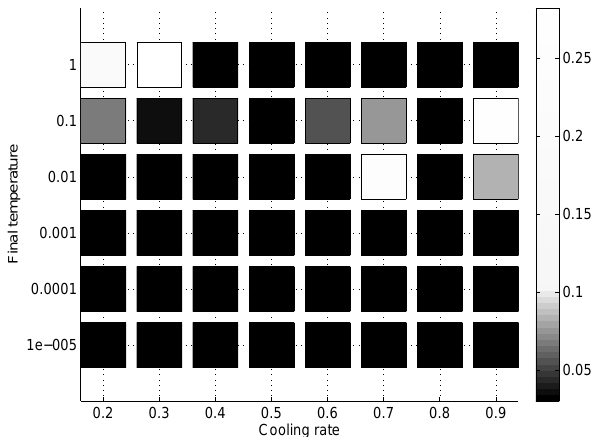
Fig. 1. Dependence of the fitness on the cooling rate δ and the final Fig. 1: Dependence of the fitness on the cooling rate δ and temperature of the final temperature of SIMPSA